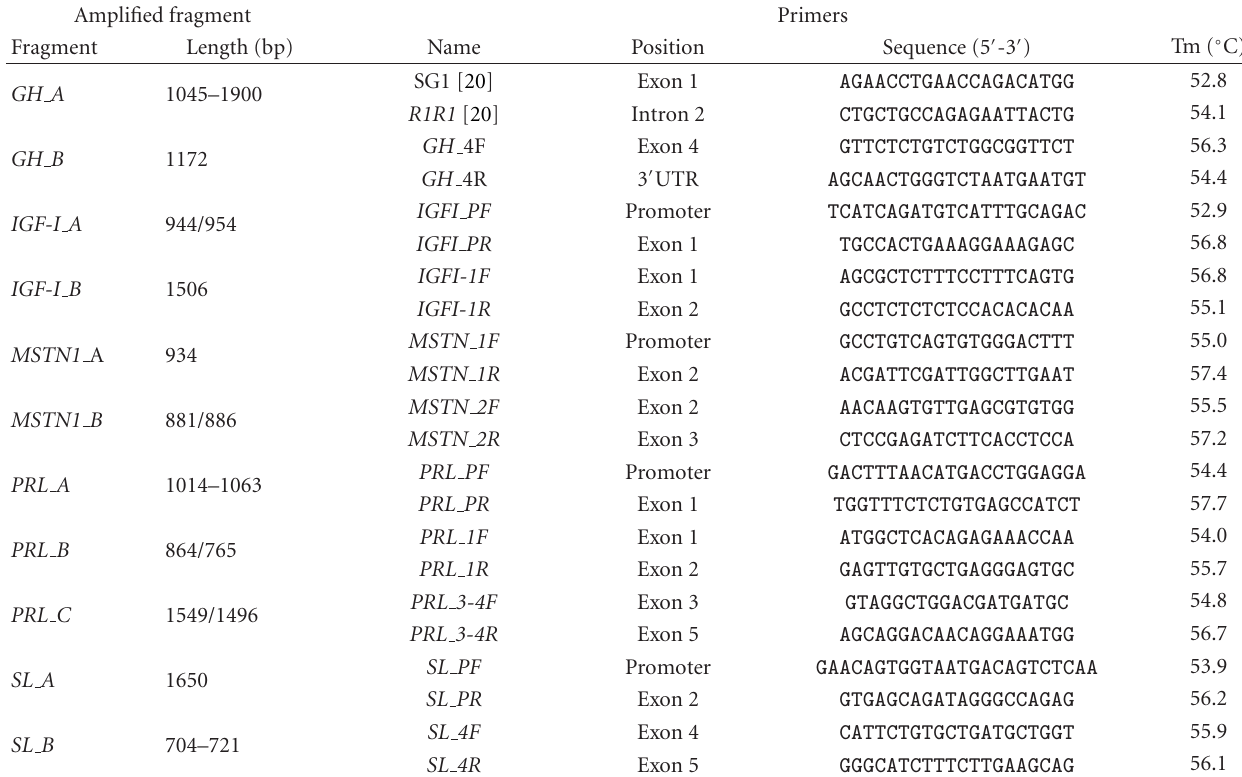
Table 2: PCR oligonucleotide primers used for RFLP analysis in the five candidate genes studied in gilthead seabream. Amplified fragment